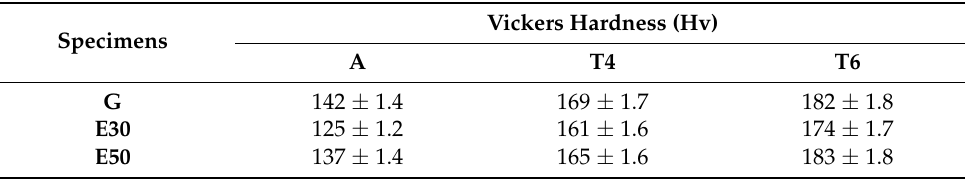
Table 2. Vickers hardness of GBF- and EMS-processed specimens of as-cast, T4, and T6 heat treatment